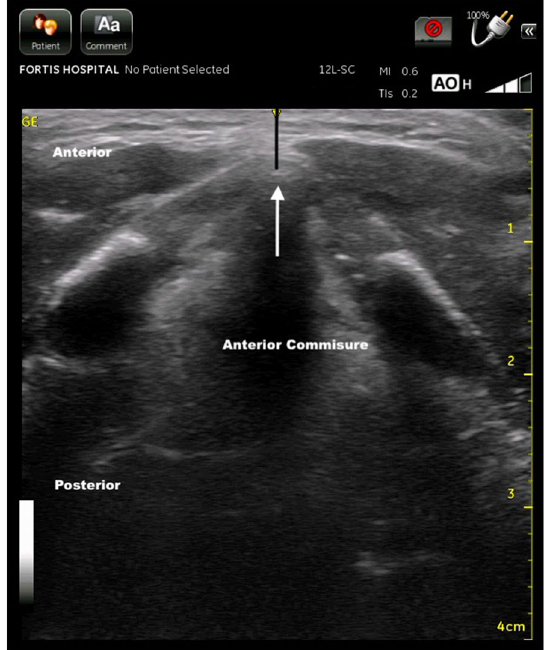
Fig. 3 Distance from anterior neck surface to anterior commissure (ANS-AC). Legend: Black line indicates ANS-AC distance